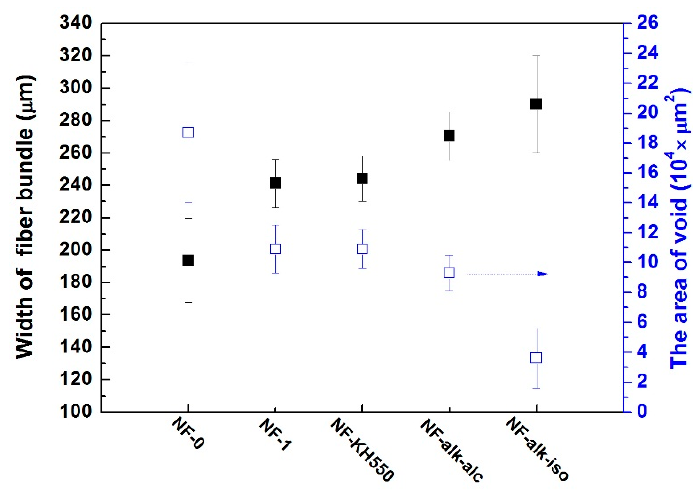
Figure 2. PLM observations of different modified ramie fabrics.